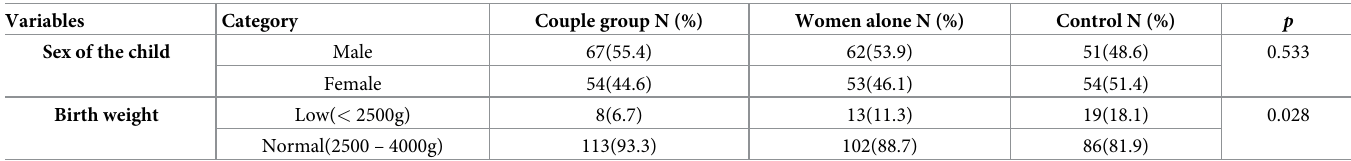
Table 3. Characteristics of the new born babies, Illu Aba Bor Zone, Southwest Ethiopia, 2019/20. Variables